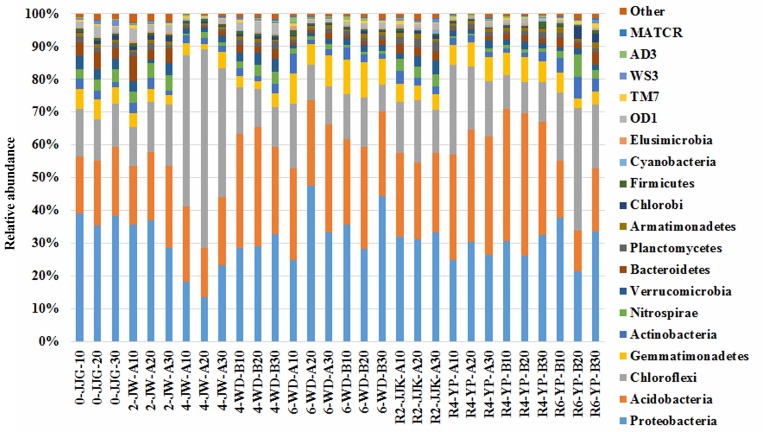
Relative abundance of bacterial phyla in 30 soil samples.Relative abundances are reported as percent of total bacterial sequences observed per samples. The other category includes phyla showing a percentage of reads <2% of the total reads in all of the soil samples.